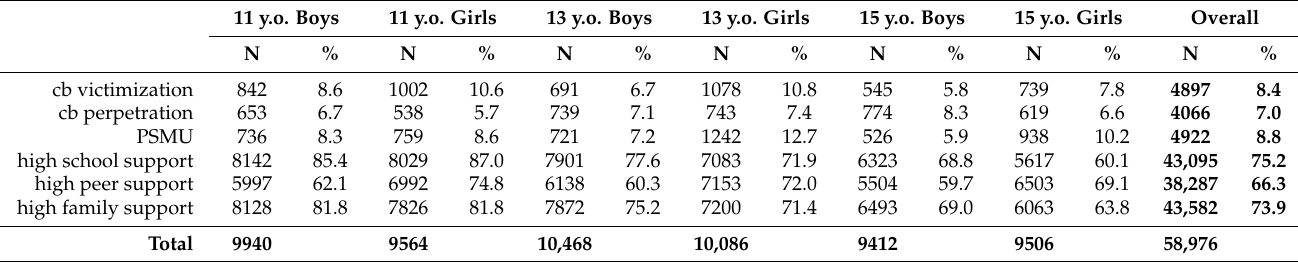
Table 1. Prevalence of cyberbullying victimization, perpetration, Problematic Social Media Use (PSMU), and perception of high social support in Italy by age and gender (Italian HBSC 2018). 11 y.o. Boys